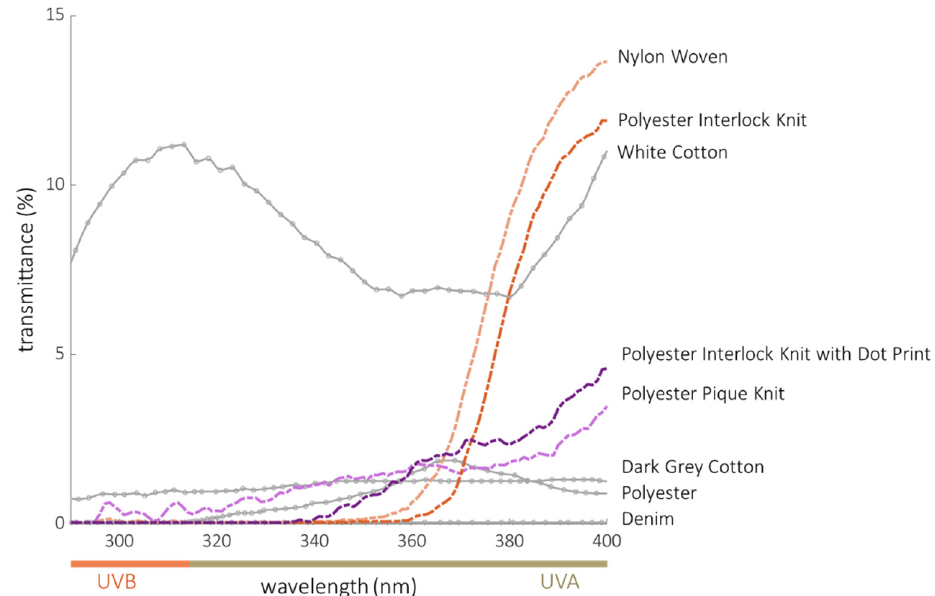
Figure 5. Transmittance spectra of the four fabrics designed for UV protection tested in this study (orange and purple lines) compared to “normal” clothing items tested by Coyne, et al. (gray lines). The data from Coyne, et al. were digitized, converted to transmittance and represent the average of the 16 measurements as reported in the original study. White cotton and dark grey cotton were GAP, Inc. 100% cotton shirts. The denim was 69% cotton, 30% polyester, 1% spandex GAP jeans. Polyester refers to a 84% polyester, 16% spandex Coolibar rash guard [71].